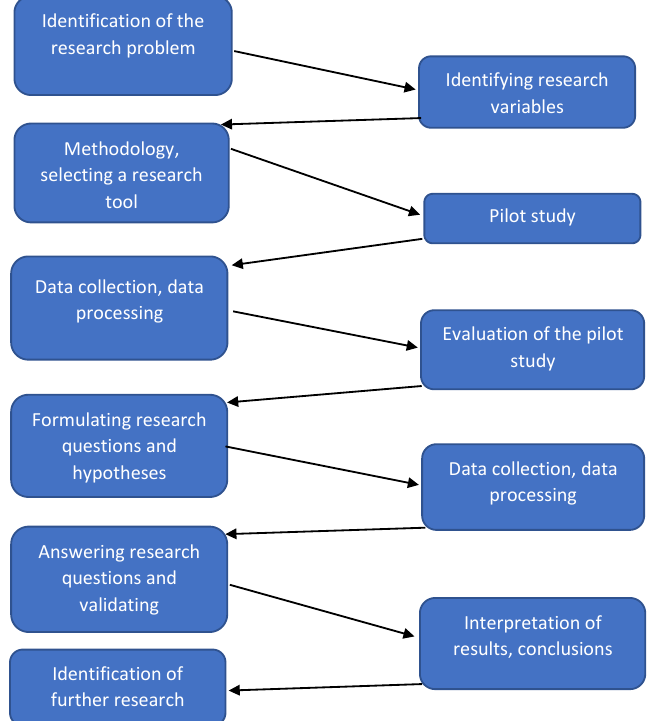
Figure 1. Flowchart of the research methodology